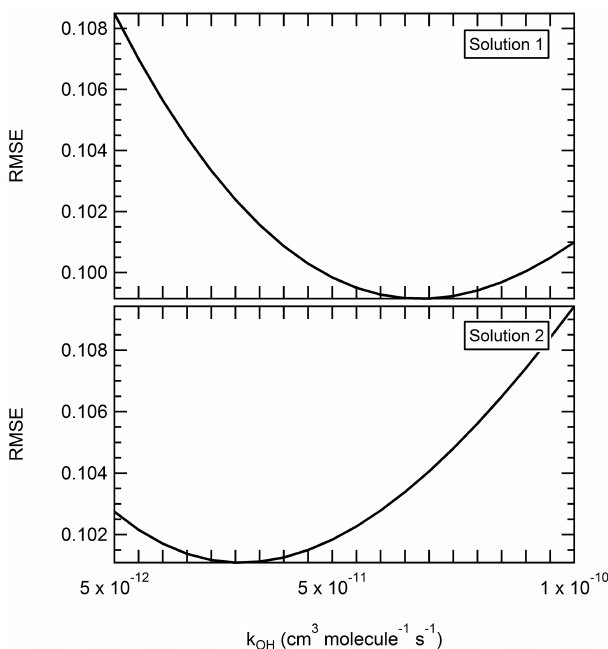
Figure 7. Effect of the reactivity on the performance of the model. The reaction rate constant k OH was varied be- tween 5 × 10 − 12 and 1 × 10 − 10 cm 3 molecules − 1 s − 1 by in- crements of 5 × 10 − 12 cm 3 molecules − 1 s − 1 . Other parameters = 8µgm − 3 , were set as follows: solution 1 – α = 0.1, C ∗ i m wall = 1.6mgm − 3 , 1 /k wall / w = 20min. Solution 2 – α = 0.1, = 8µgm − 3 , m = 3.2mgm − 3 , 1 /k = C ∗ wall wall / w i